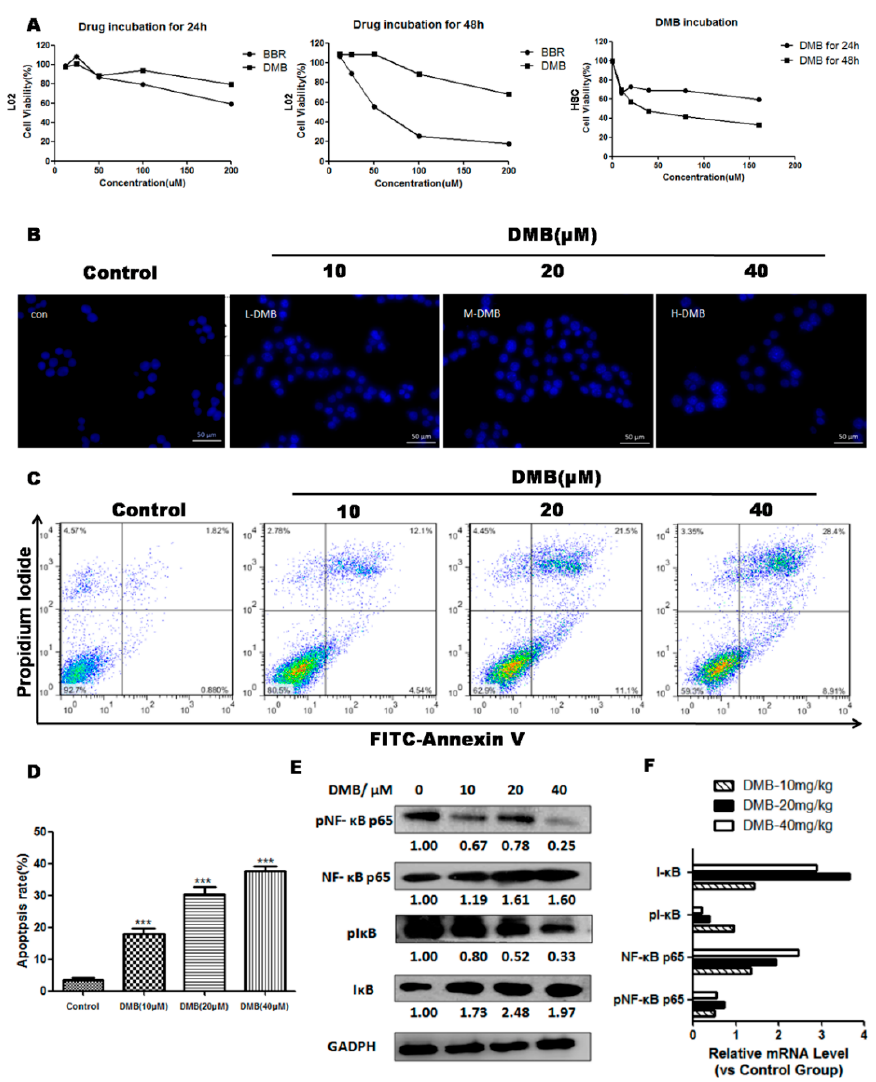
performed flow cytometry by Fluorescein isothiocyanate (FITC)-labeled annexin V/propidium iodide (PI) staining (Figure 6C,D). The results exhibited that DMB could induce a significant dose-dependent increase in apoptosis of HSC-T6 when compared with the control group. In addition, we treated normal hepatocyte L02 using DMB, but little apoptosis was detected, which suggested that DMB The IC 50 value of DMB for HSC-T6 cells at 48 h was 36.7 µ mol/L. Therefore, we chose 0, 10, 20 and triggers apoptosis specifically in HSCs (Figure 6A). 40 µ mol/L for further experiments.